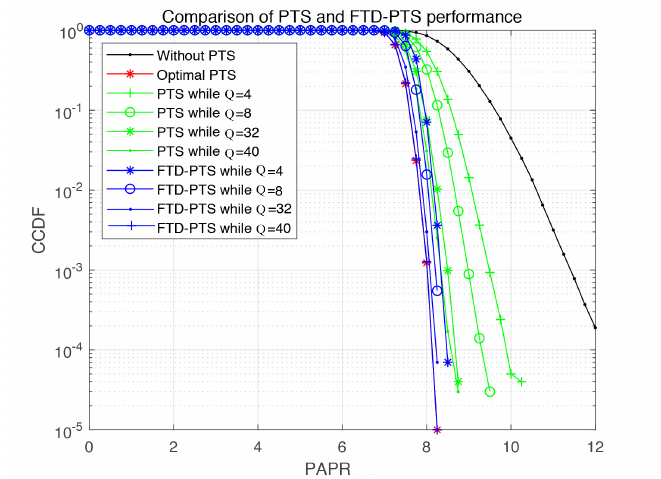
Figure 11. The performance comparison of FTD-PTS and PTS with different Q